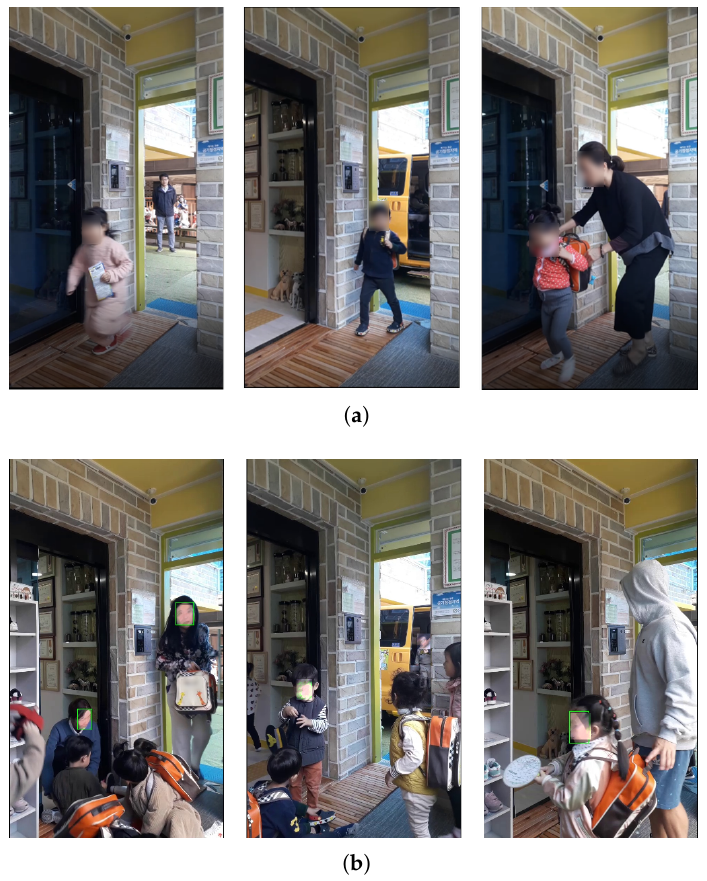
Figure 5. Example of an images taken with a camera installed at the entrance of the actual daycare center (Figure 4b): ( a ) best; ( b )